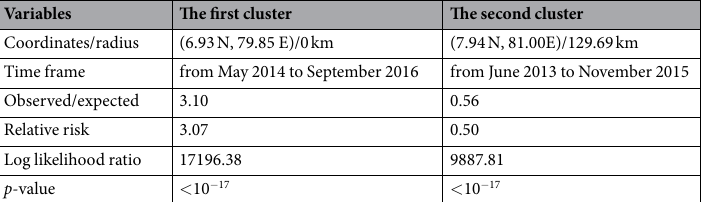
as a low-incidence period. The sample means and variances of climatic factors for clustering and non-clustering periods were different. During the clustering period, the sample mean of the humidity was smaller, while the sample means of the maximum and mean wind speed were much larger, and the sample means for precipitation